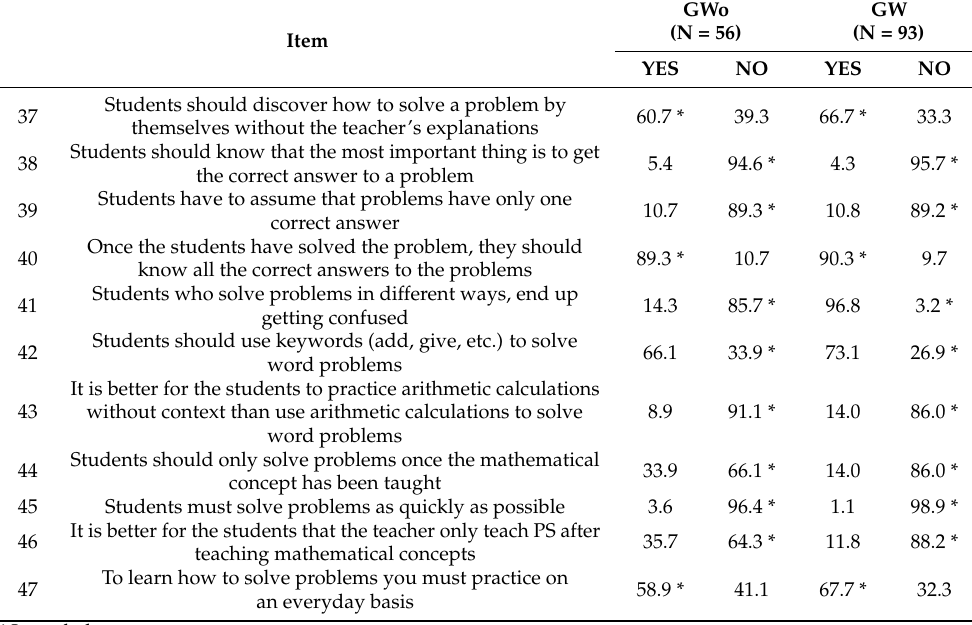
Table 3. Percentages of responses of knowledge of non-cognitive